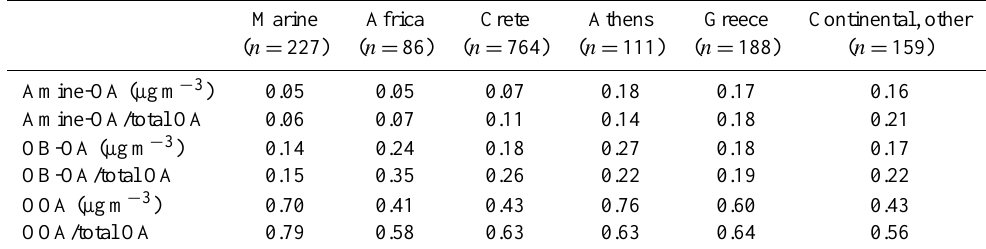
Table 1. Contributions of OA components by source region.